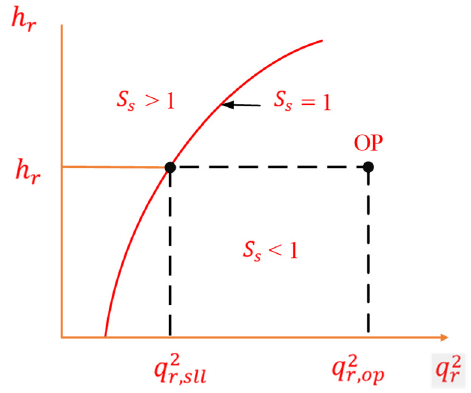
Figure 9. The surge parameter limits